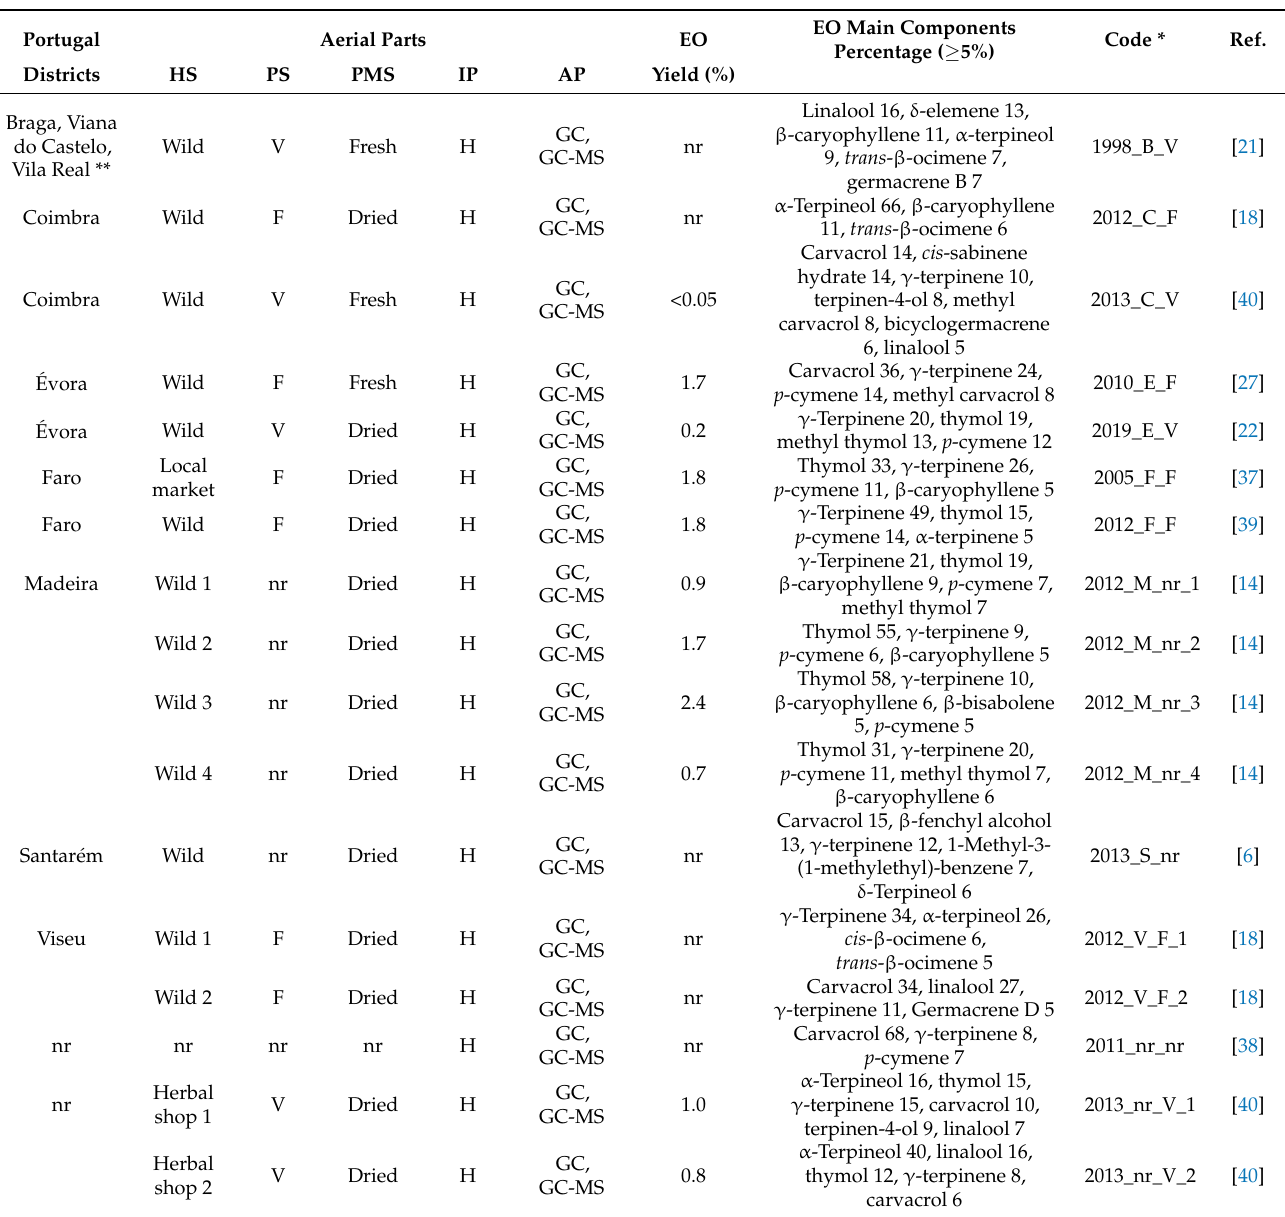
Table 3. Previous studies on Portuguese Origanum vulgare EOs.